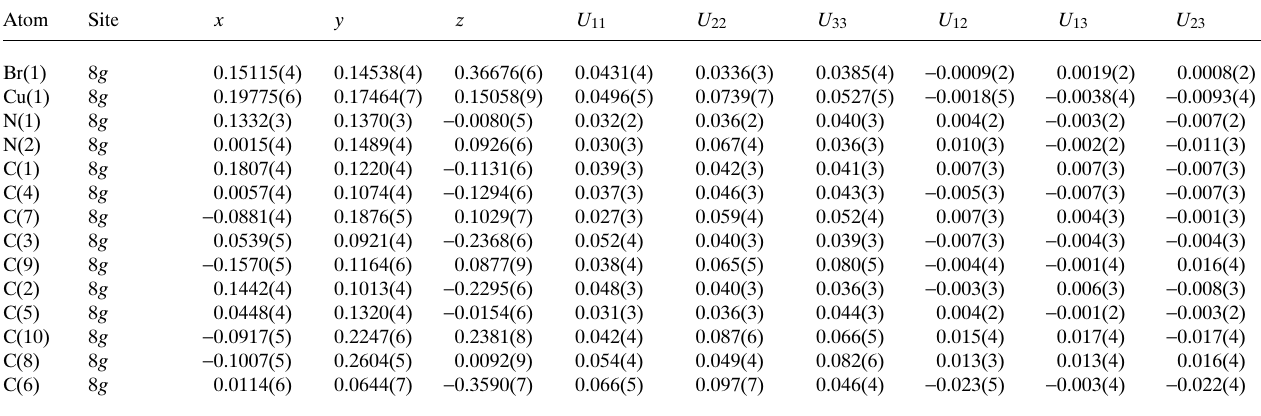
Table 3. Atomic coordinates and displacement parameters (in Å 2 )